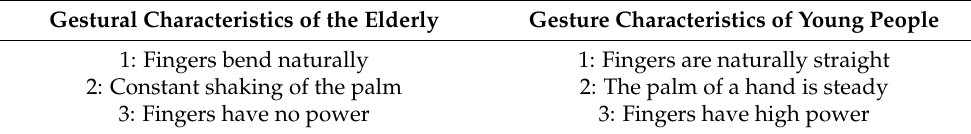
Table 1. Comparison of gesture characteristics between the elderly and the young.